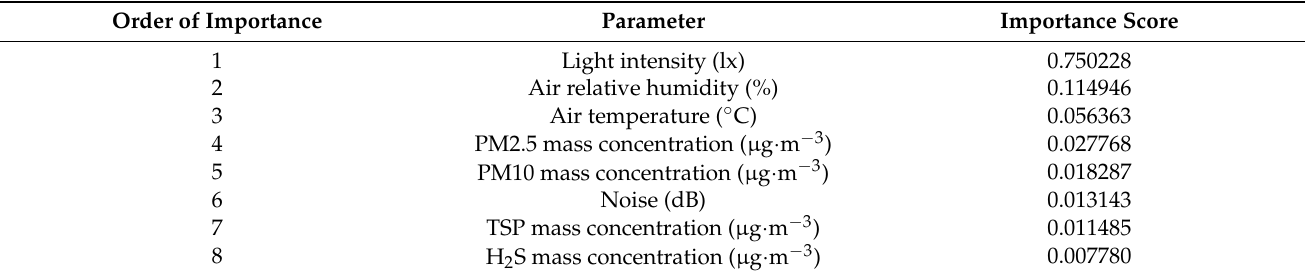
Table 6. Eight parameter features ranked by